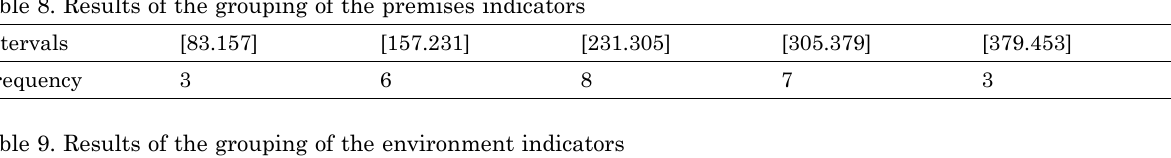
table 9. results of the grouping of the environment indicators Intervals